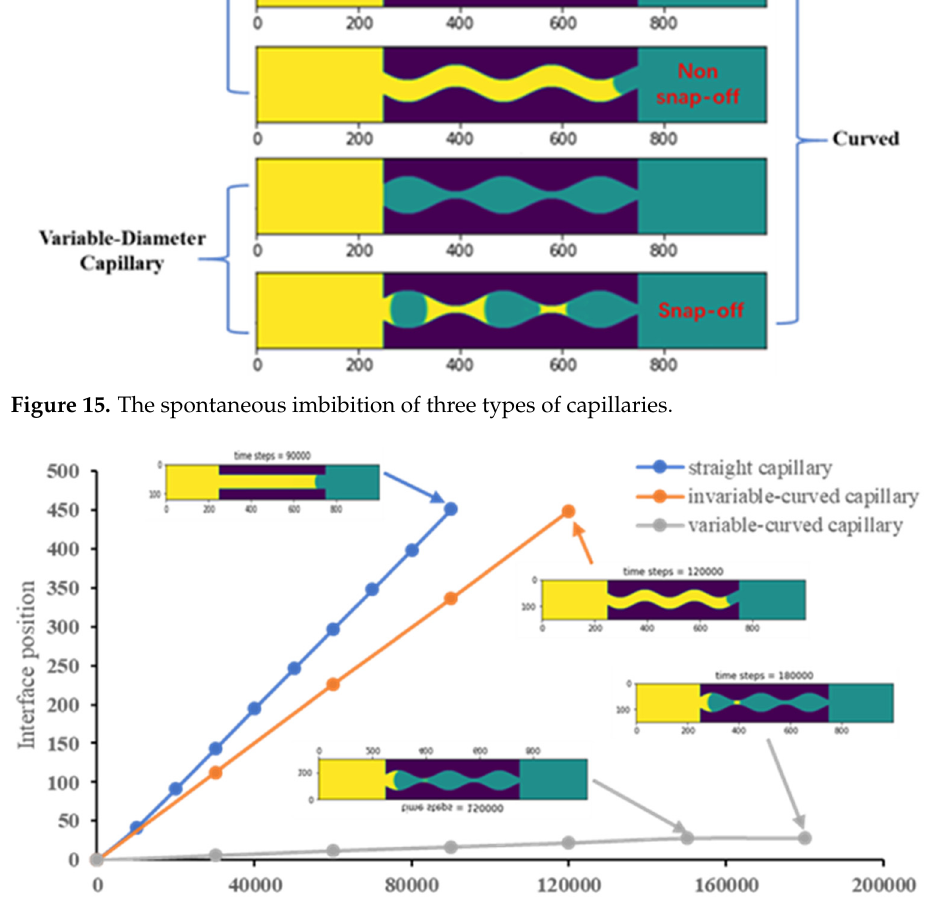
Figure 16. The spontaneous imbibition front position of three types of capillaries.